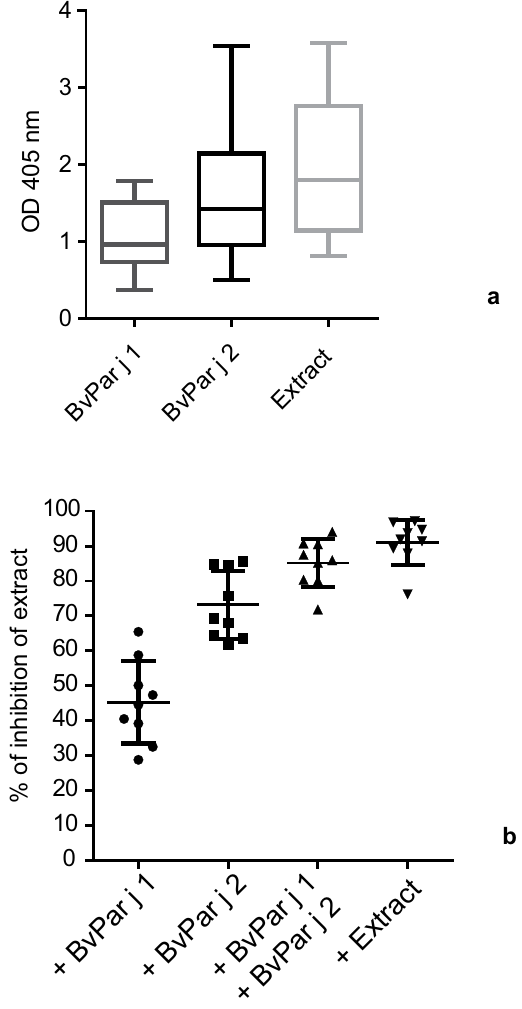
Figure 7. Contribution of Par j 1 and Par j 2-specific IgE to IgE specific for natural Parietaria allergens. OD values corresponding to IgE levels specific for BvPar j 1, BvPar j 2 and natural Parietaria judaica pollen extract are shown as (a) box plot representation (whiskers = minimum and maximum; boxes = 25 th to 75 th percentiles, means: horizontal bars) (y-axis: OD values). (b) Inhibition of IgE binding of sera to Parietaria judaica extract by pre-incubation of sera with BvPar j 1, BvPar j 2, with a mix of the two proteins or with extract. Scatter plots showing the percentages of inhibition of IgE binding, horizontal lines indicate means ±